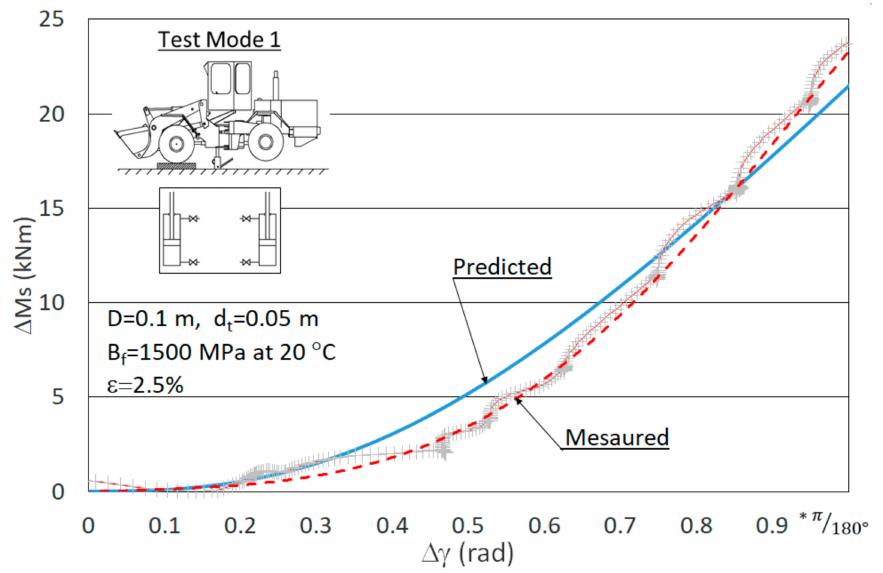
Figure 14. Validation of the mathematical model of the equivalent torsional stiffness k s of a hydraulic steering system on a test